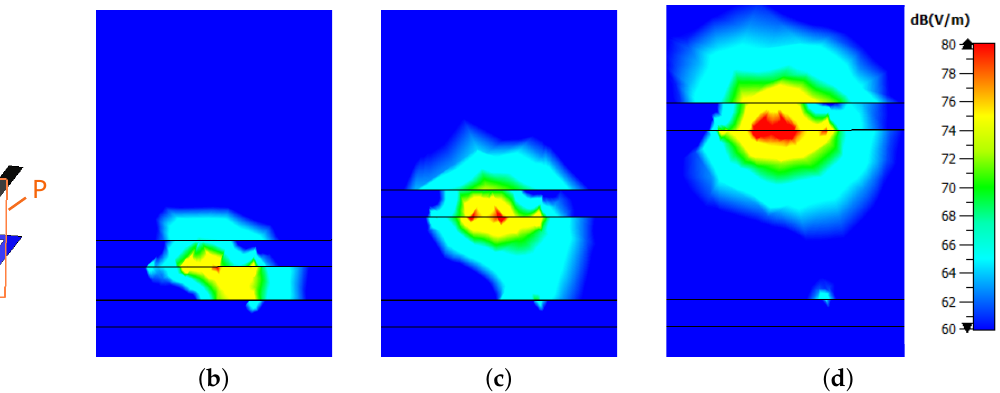
Figure 9. ( a ) 3D view of the sensor (dielectric substrates are hidden for better visibility) showing the section plane P where the electric field distribution is plotted for ( b ) d z = 2 mm (at 379 MHz), ( c ) d z = 5 mm (at 406 MHz), ( d ) d z = 10 mm (at 416